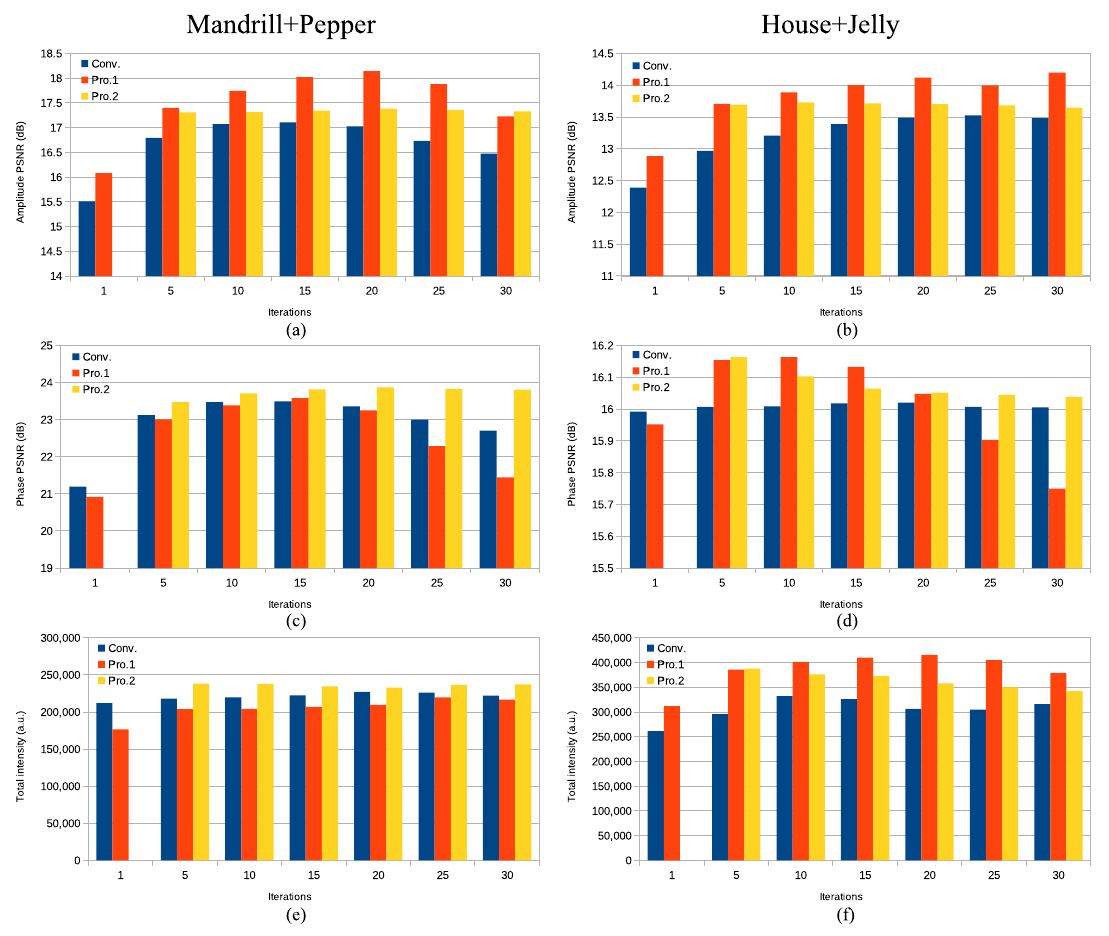
Figure 6. Reconstructed amplitude images, phase images, and total intensity as a function of the iterations. The resolution of the hologram is 1024 × 1024 pixels. The peak signal-to-noise ratios (PSNRs) and total intensities were averaged with five different initial random phases. ( a , b ) are the amplitude PSNRs for “Mandrill+Pepper” and “House+Jelly”, ( c , d ) the phase PSNRs for “Mandrill+Pepper” and “House+Jelly”, and ( e , f ) are the total intensities for “Mandrill+Pepper” and